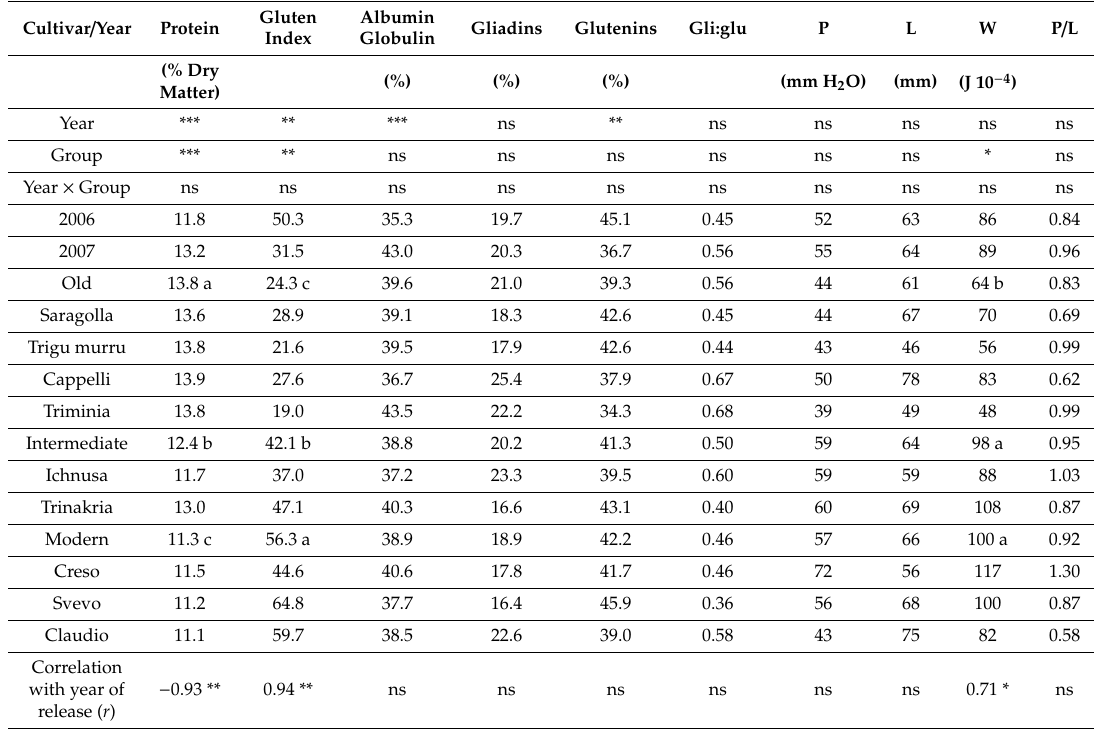
Table 5. Semolina protein, gluten index, gli:glu and alveographic indices. ANOVA results, means, and coe ffi cient of correlation ( r ) with the year of